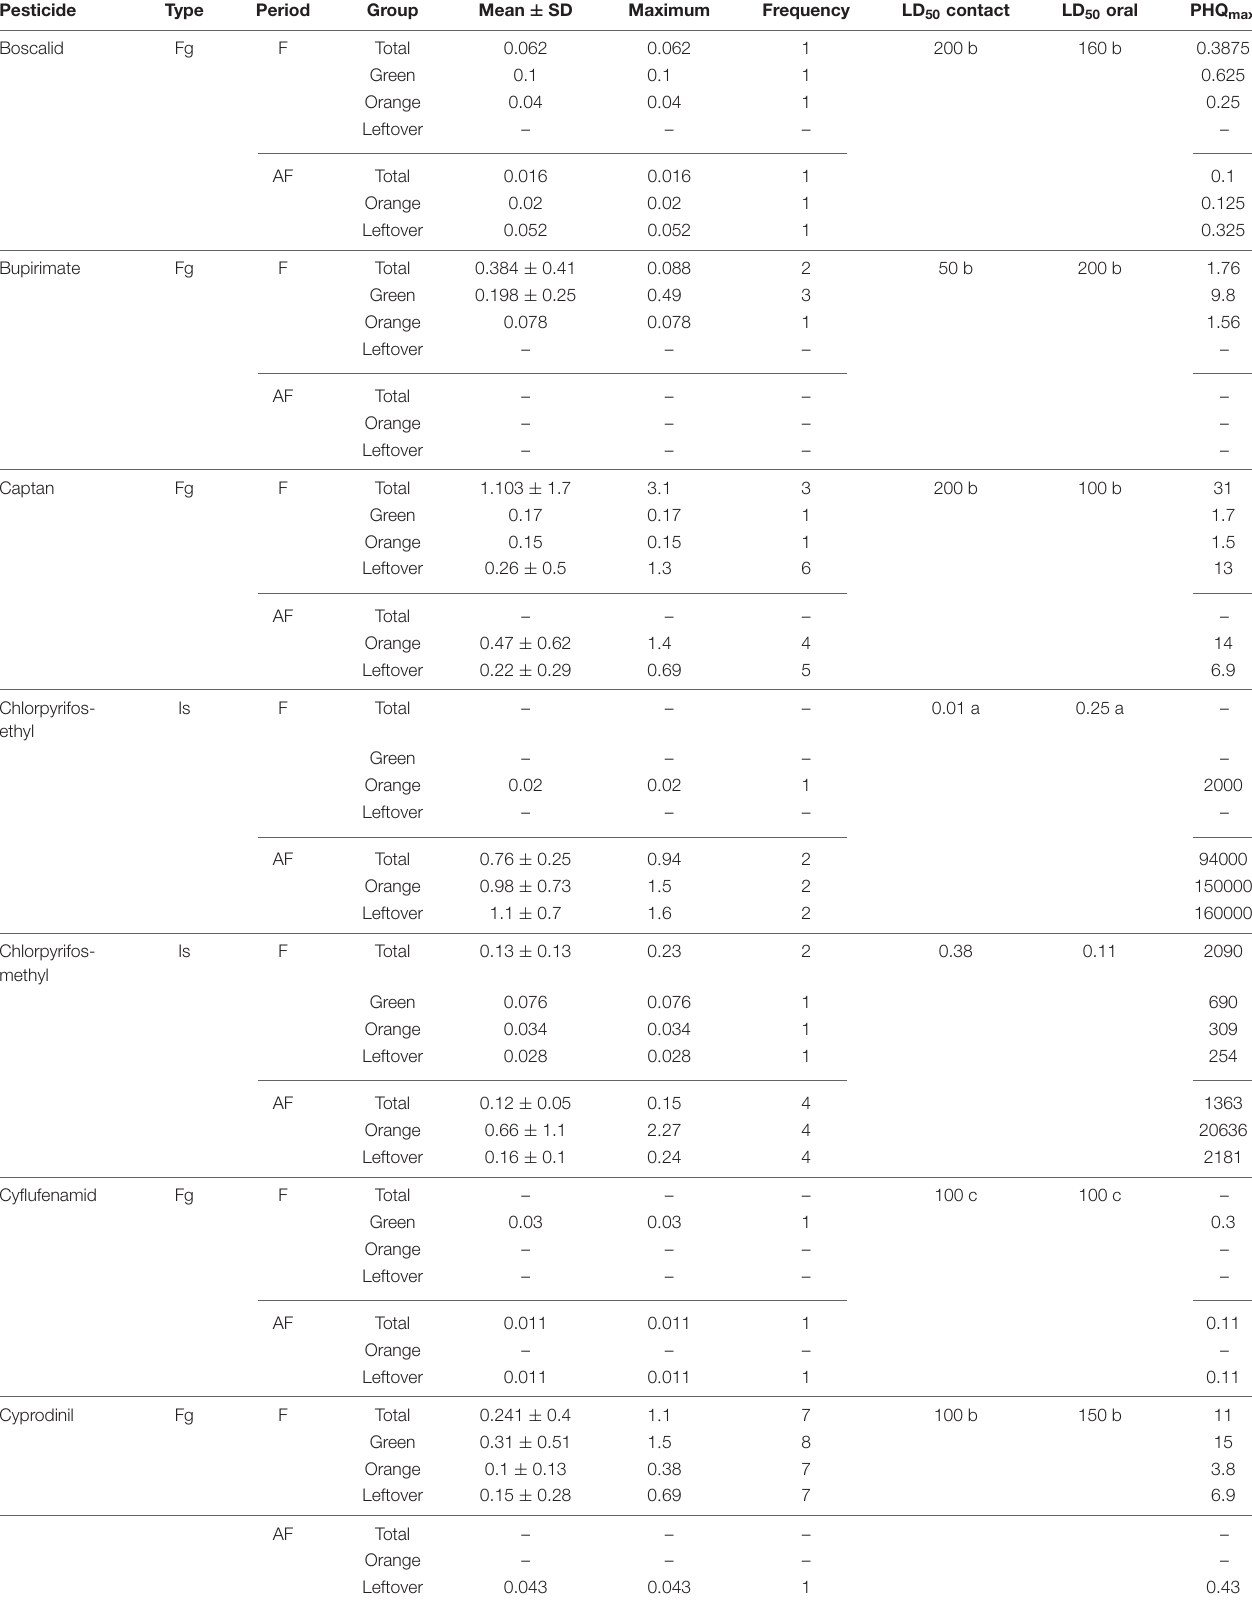
TABLE 4 | Summary of the 36 pesticides detected in honey bee pollen loads collected during and after apple blossom and separated by color.